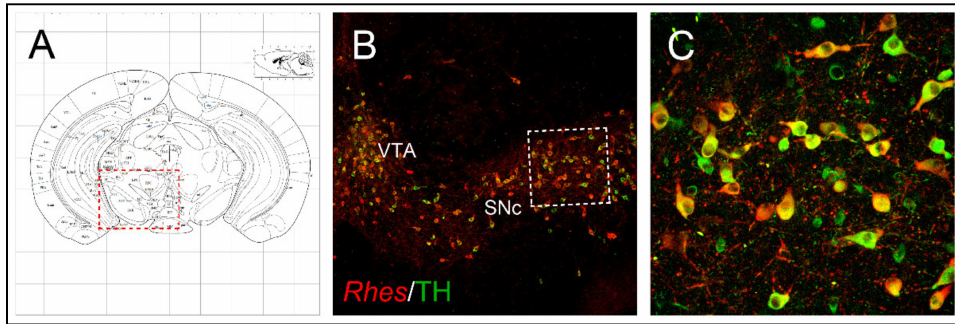
Figure 2. Rhes expression in midbrain dopaminergic neurons. ( A ) Schematic representation of a coronal section at the level of the midbrain. ( B , C ) Confocal images of brain coronal sections showing expression of Rhes in SNc and VTA TH-positive DA neurons. The figure has been adapted from Pinna et al.